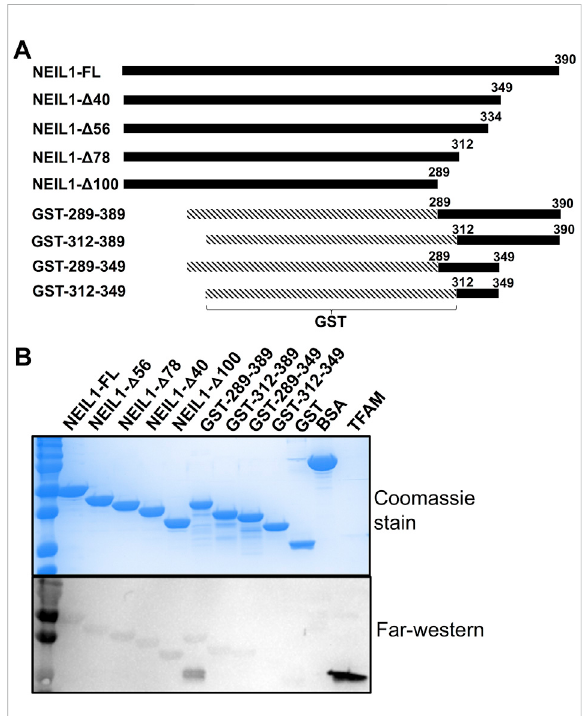
FIGURE 3 Far-western analysis indicates that NEIL1 interacts with TFAM via multiple binding sites present at both the N- and C-terminal domains. (A) A map of the His-tagged polypeptides of NEIL1 lacking portions of the C-terminal disordered tail and the GST-tagged C-terminal polypeptides of NEIL1 lacking the N-terminal portion of the enzyme. (B) Far-western analysis to determine the minimal region of NEIL1 required for interaction with TFAM. All proteins used in this study were expressed in E. coli , puri fi ed to homogeneity, and veri fi ed by sodium dodecyl sulfate- polyacrylamide gel electrophoresis (SDS-PAGE) analysis stained with Coomassie blue. 50 pmol of NEIL1 and the truncated enzymes, bovine serum albumin (negative control), glutathione S-transferase (negative control), and 1 pmol of TFAM (positive control) were loaded onto the gel. Far-western analysis was performed where proteins were transferred to a PVDF membrane, denatured, slowly renatured on the membrane, incubated with 10 pmol/ml puri fi ed TFAM, and probed with an anti-TFAM antibody to detect an